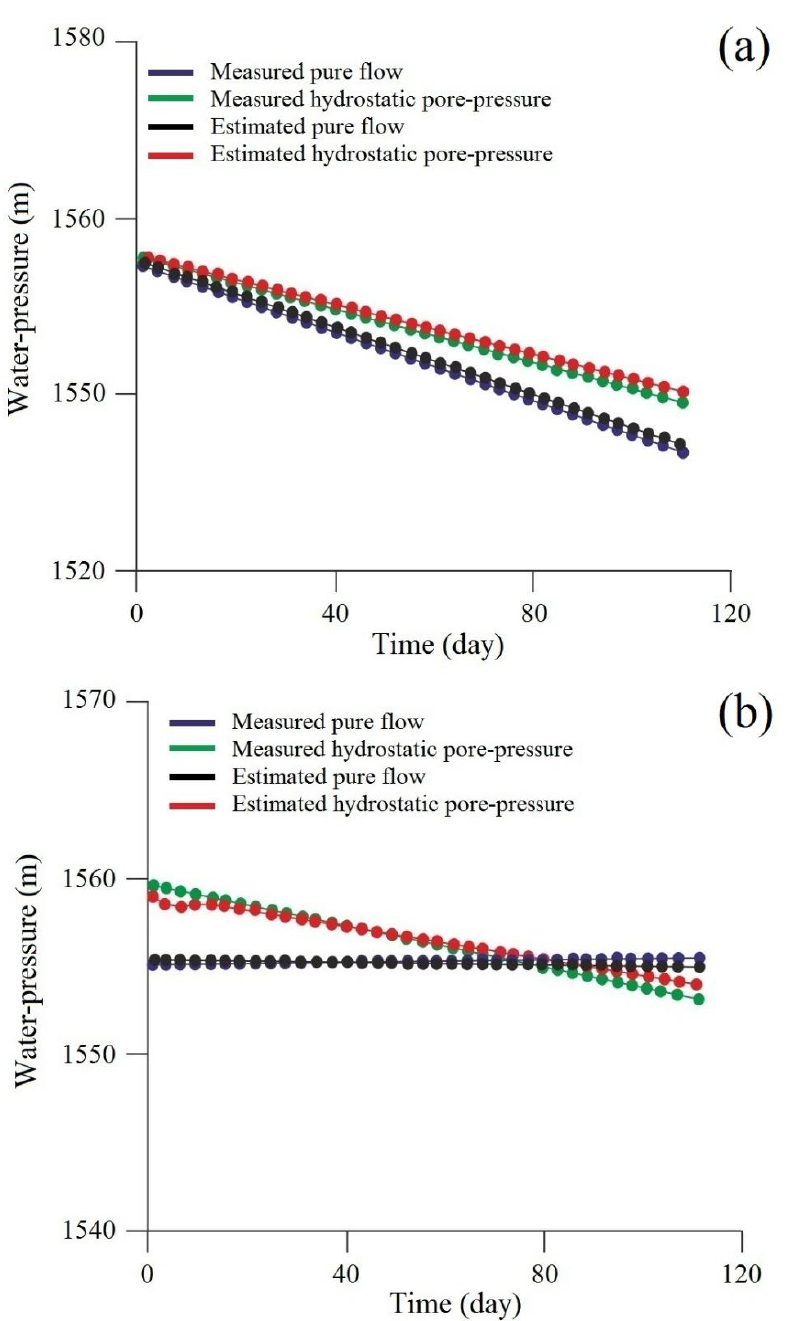
Figure 12. The comparative results of coupled FEM/LEM modeling with instrumentation: ( a ) up- stream shell, ( b )